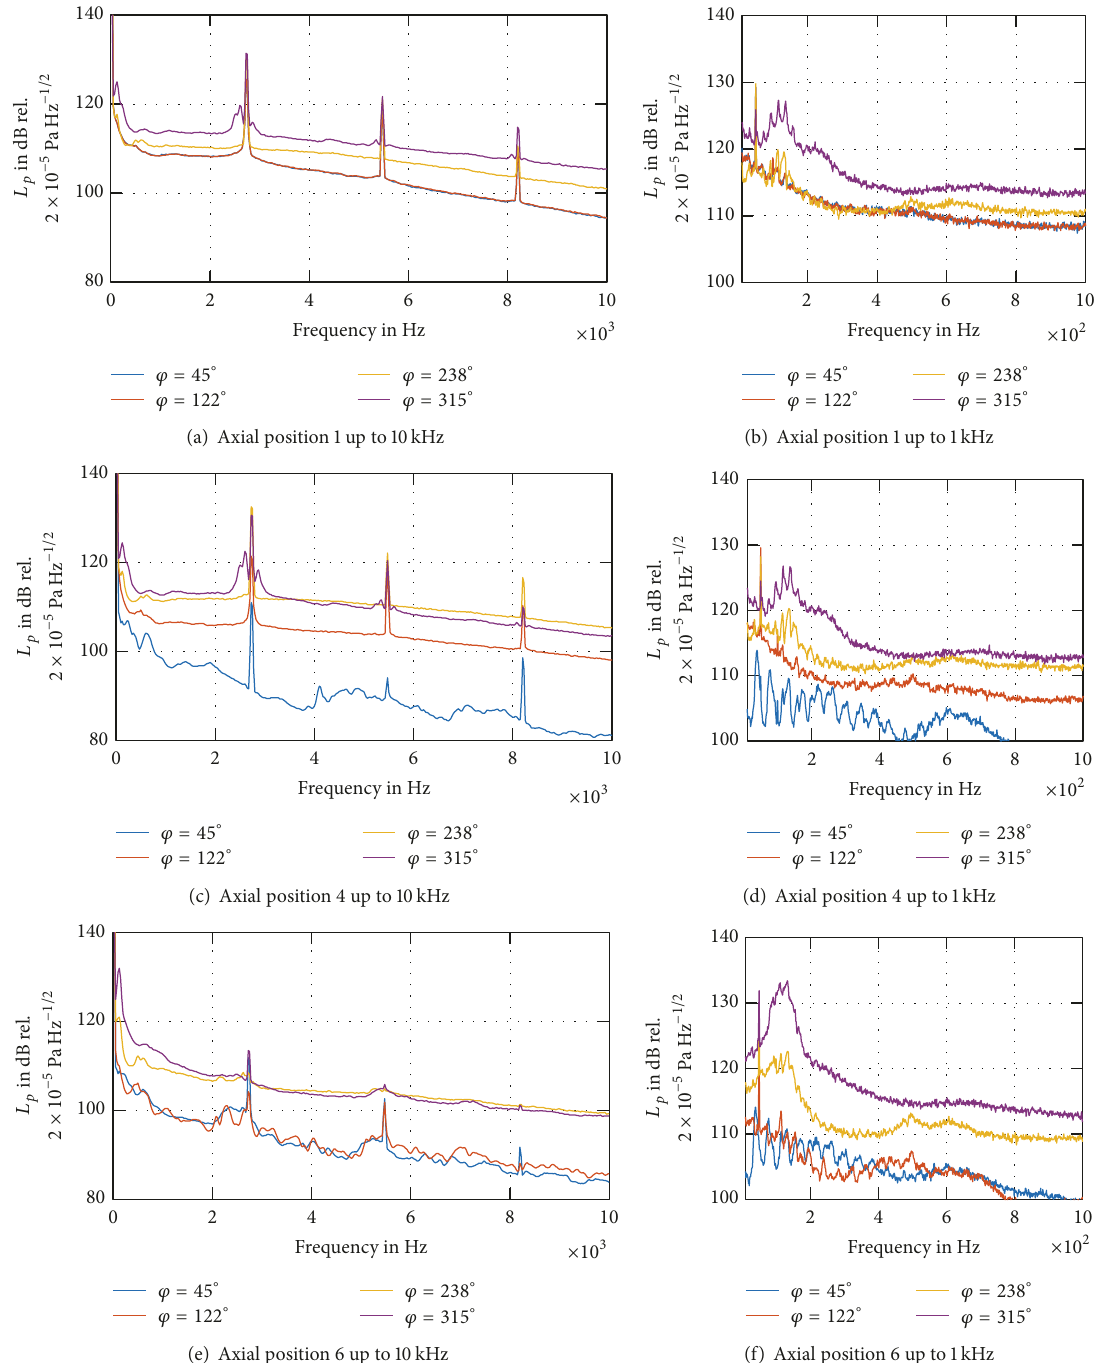
Figure 19: PSD of wall pressure at a rotational speed of 50 Hz and Δ𝑝 12, red = 28,000Pa. Each plot contains the same axial position for different circumferential